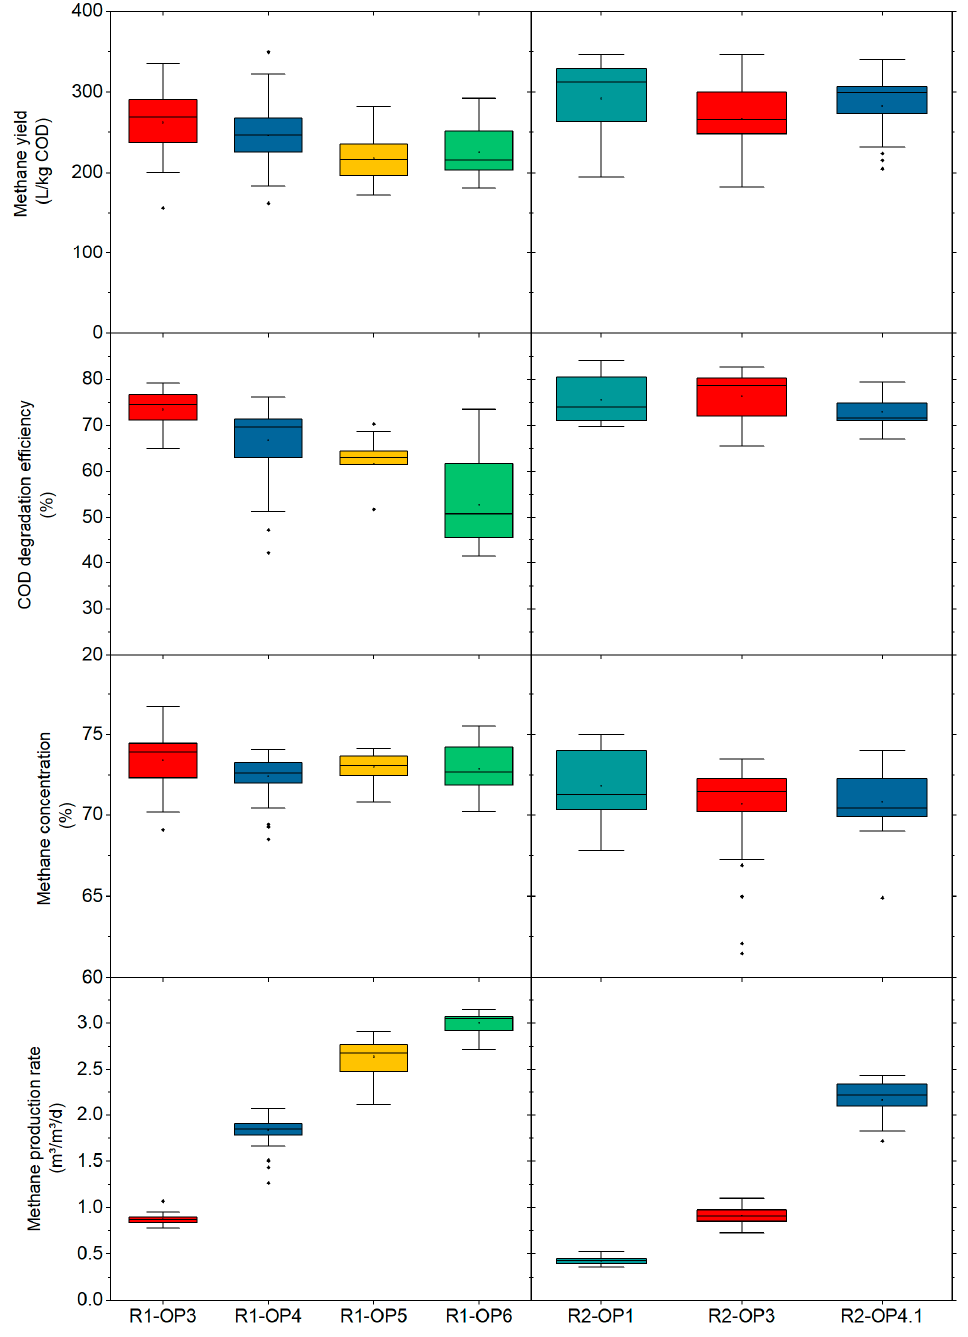
Figure 4. COD-specific MY, COD degradation efficiency, methane concentration, and methane production rate at OPs in R1 and R2.